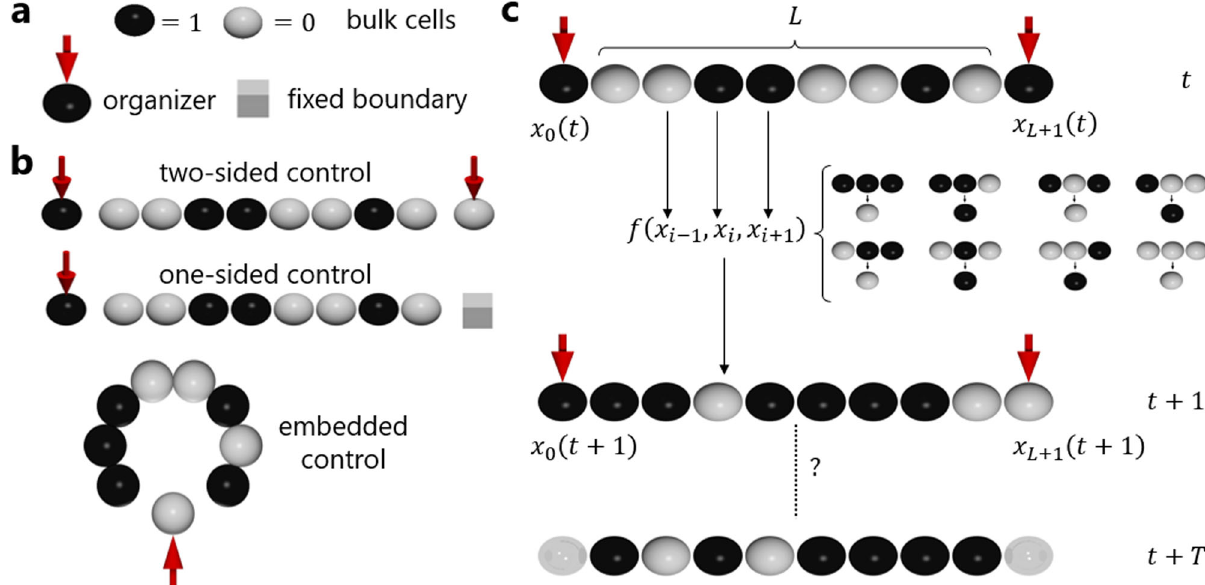
Fig. 1 Programmable pattern formation within a cellular automaton (CA) model. a The model features bulk cells (spheres) and organizer cells (marked by red arrow). The state of cells is represented by their color. Fixed boundary cells (boxes) can also be regarded as organizer cells that never change their state. b We consider three types of cell arrangement: Linear, with either one or two organizer cells, and circular. c The patterning dynamics of bulk cells follows a cellular automaton rule. The time-dependent state x i ð t Þ of each of the L bulk cells is updated according to x i ð t þ 1 Þ ¼ f ð x i (cid:2) 1 ð t Þ ; x i ð t Þ ; x i þ 1 ð t ÞÞ , with a rule f that maps every triple of input states ð x i (cid:2) 1 ð t Þ ; x i ð t Þ ; x i þ 1 ð t ÞÞ to an output state x i ð t þ 1 Þ , as speci fi ed by a transition table (small spheres). The rules are enumerated by translating the pattern of output states, ordered by the descending binary equivalent of the input states, into a binary number (here: 01010110 2 , i.e., rule 86). The patterning process is controlled by the local dynamics of the organizer cells, which supply the patterning input. Programmable pattern formation in a cell arrangement with a given CA update rule refers to the ability of the organizer cell(s) to reproducibly steer the bulk cells to different target patterns within T time steps, using appropriate sequences of